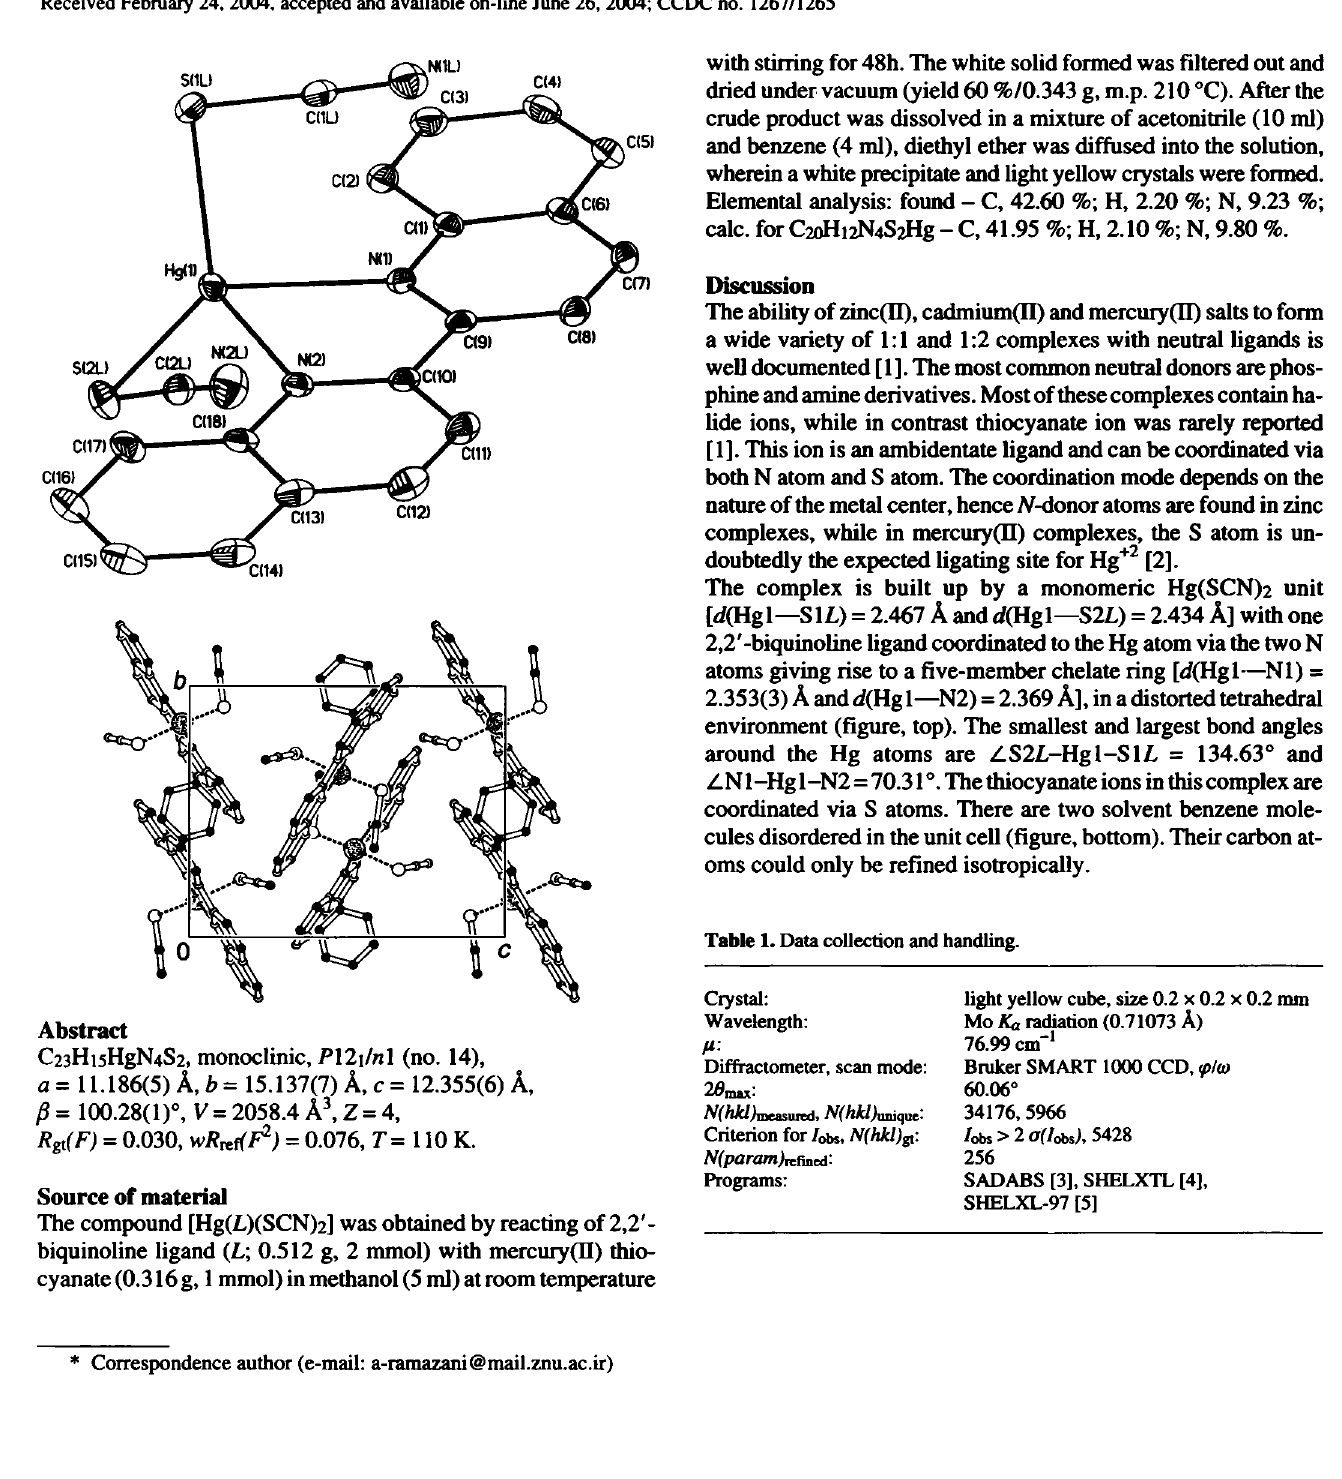
Table 1. Data collection and